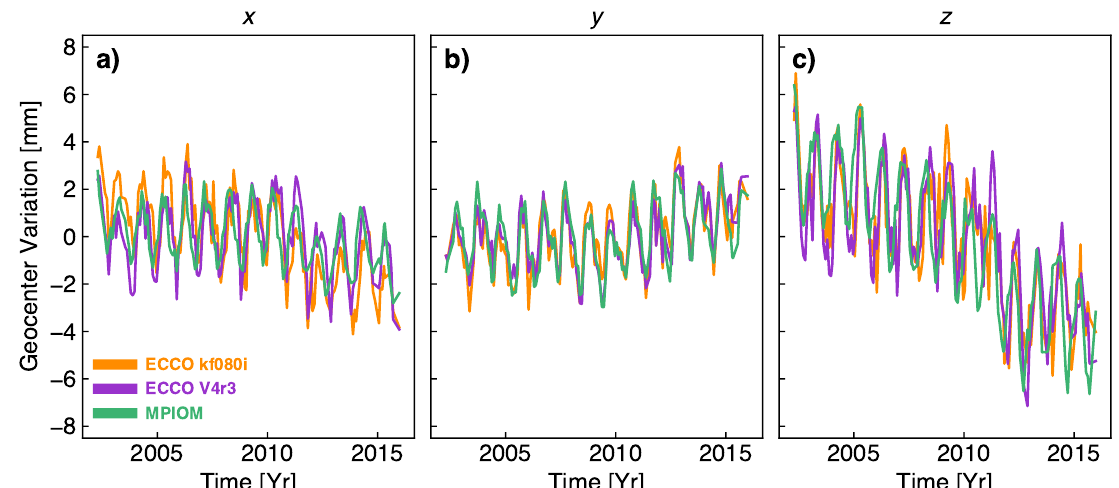
Figure 7. Time series of recovered geocenter variations, ( a ) x , ( b ) y and ( c ) z , in mm calculated using an iterated self-consistent geocenter with self-attraction and loading effects from time-variable gravity fields provided by the Center for Space Research using ocean bottom pressure outputs from ECCO-JPL real-time Kalman-filtered simulations (orange) [36], ECCO Version 4 Release 3 simulations (purple) [38], and Max Planck Institute ocean model (MPIOM) [24]. Table 2. Geocenter motion annual amplitudes, annual phase, and trends for 2002–2015 derived using time-variable gravity fields from the Center for Space Research (CSR) using ocean bottom